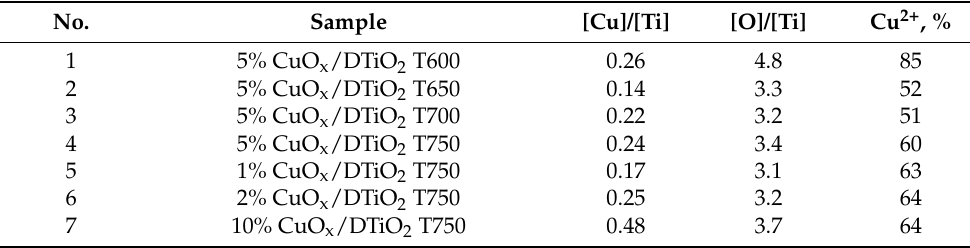
Table 2. Surface contents of atoms for the analyzed photocatalysts according to XPS